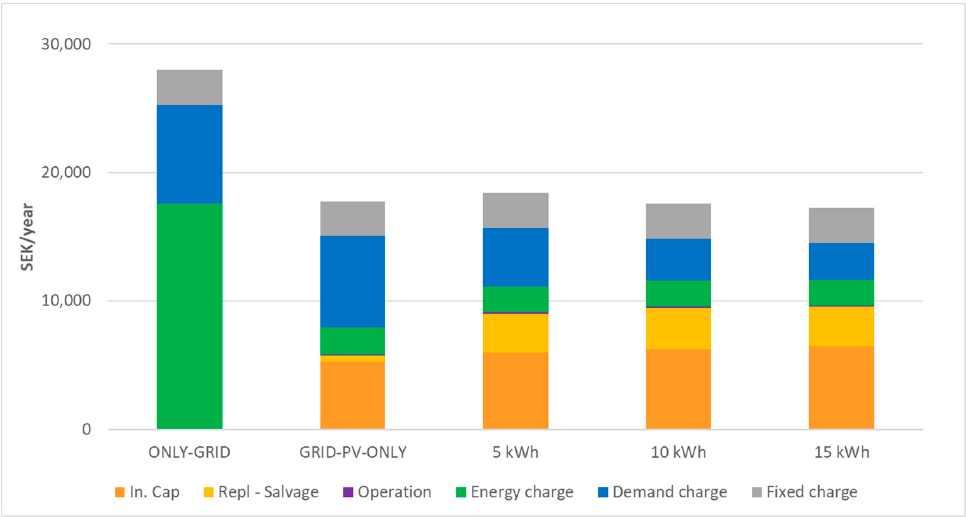
Figure 8. Discounted annual cost details for load 1, utility 1.